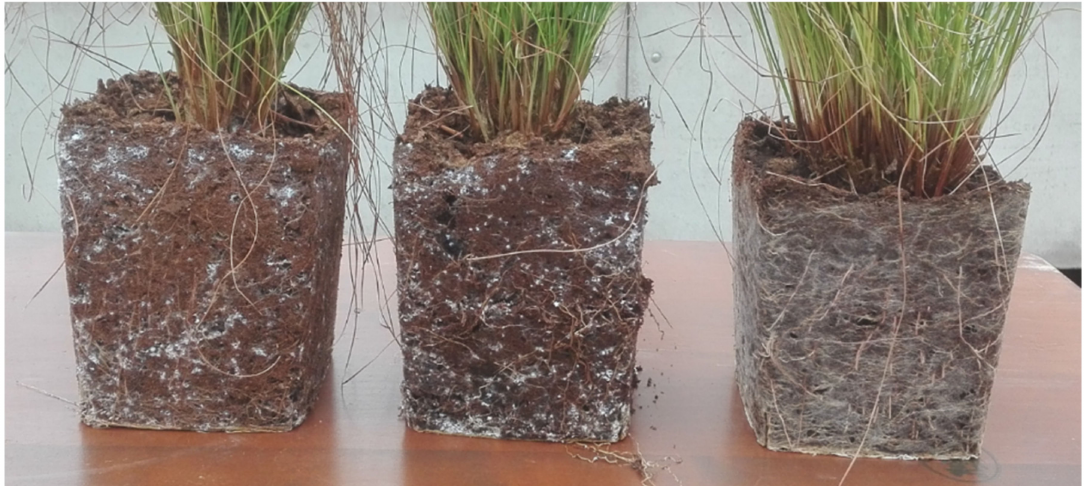
Figure A1. Soil of the Eriophorum plants prior to harvest. Left side: substrate contains 0% SiO 2 , Middle: substrate contains 1% SiO 2 , Right side, substrate contains 10% Si. White points in the left and middle sample are root aphids ( Rhizoecus ssp.). The Si 10% treatment showed no